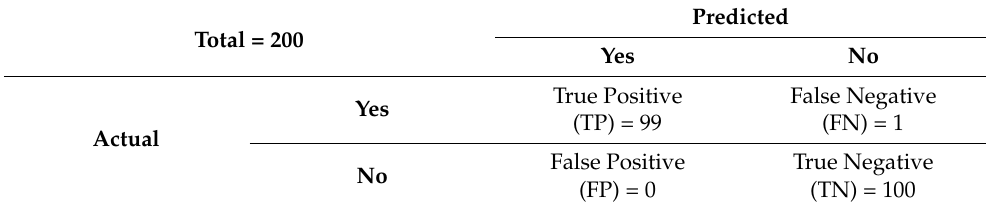
Table 11. Results for Relay#12.